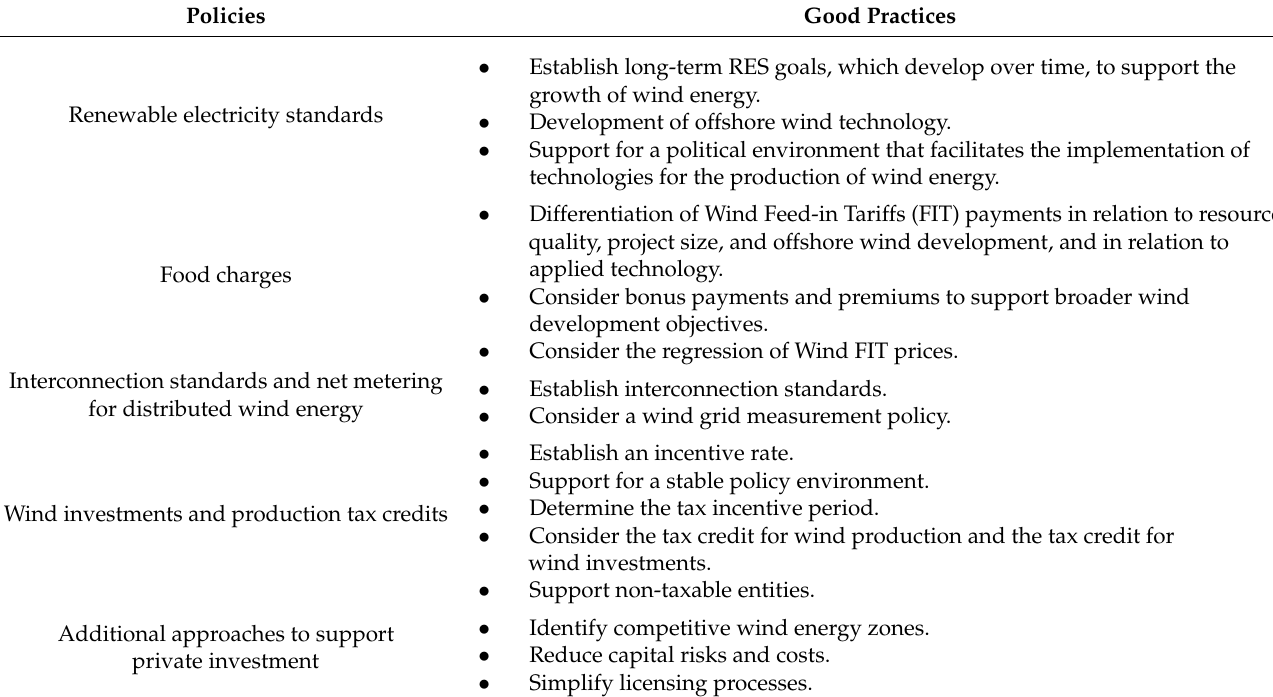
Table 5. Policies and good practices for the implementation of offshore wind